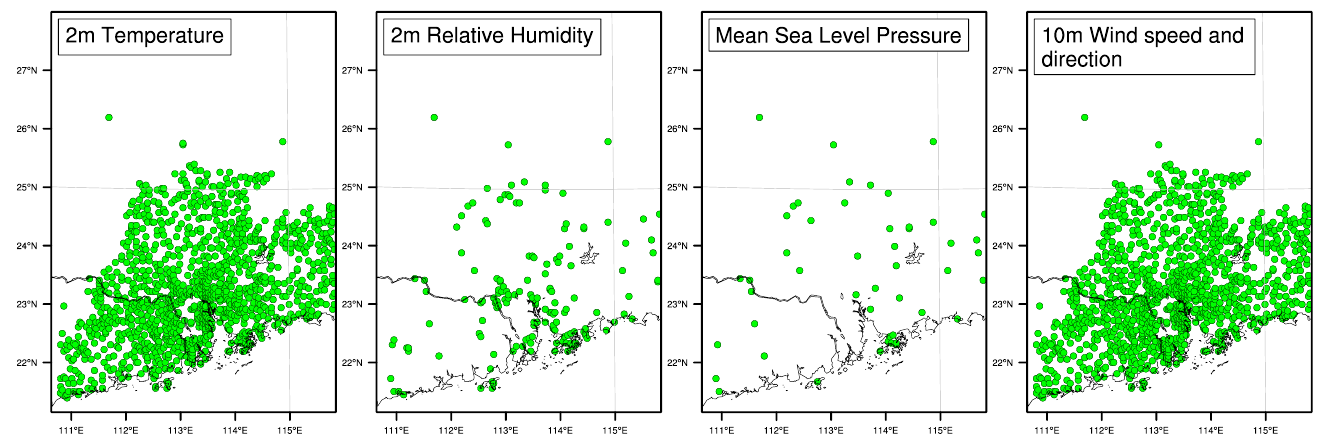
Figure 2. The distribution of the observation data that are used to evaluate the performance of the model. All the observations are situated within the Guangdong province which is covered by domain 3 (D3) of the model (Figure 1).